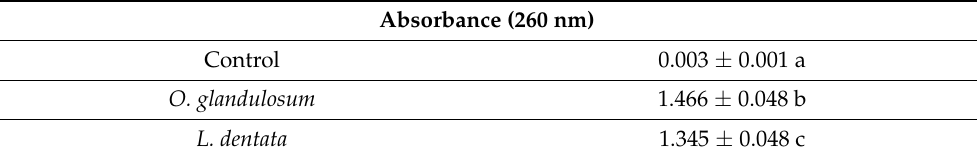
Table 3. Effect of essential oils from L. dentata and O. glandulosum , tested at MIC values (40.6 mg/mL of L. dentata EO; 5.2 mg/mL of O. glandulosum EO) on the release of the 260 nm absorbent material from ESBL K. pneumoniae . Lower case letters denote significant difference at p < 0.05 between samples.